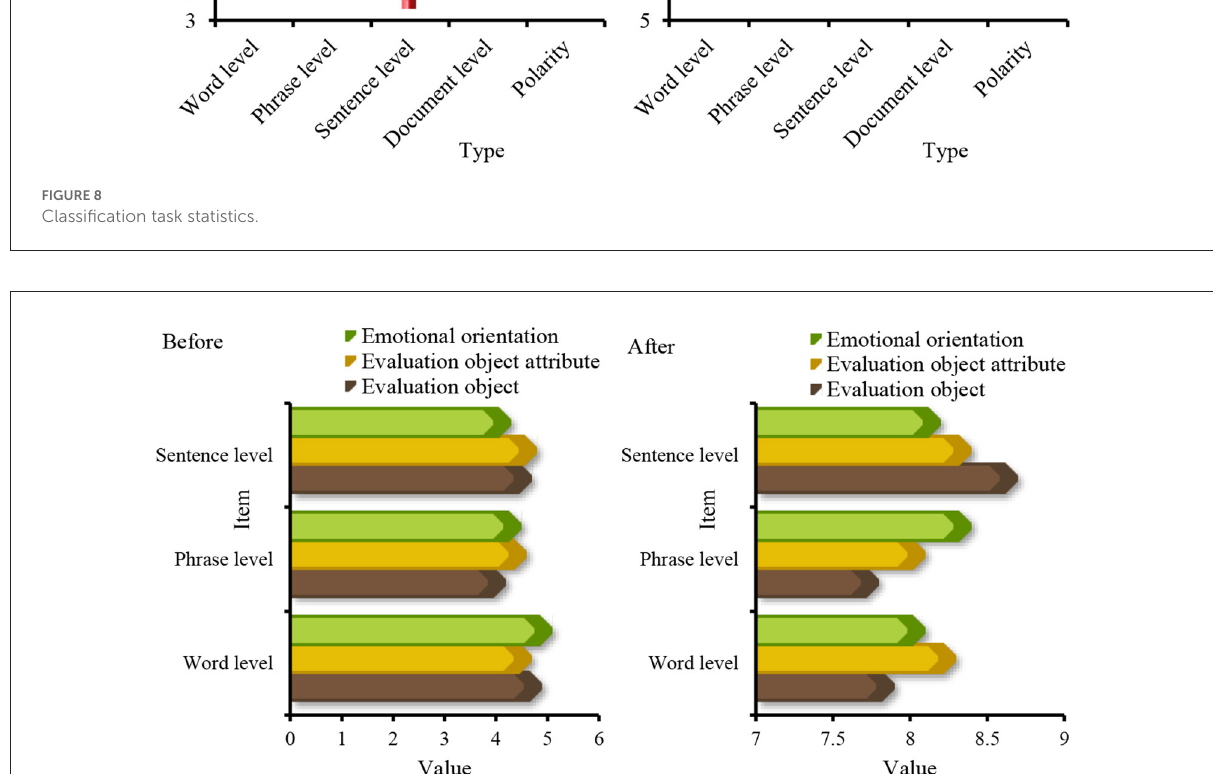
FIGURE9 Sentiment analysis from the perspective of discourse